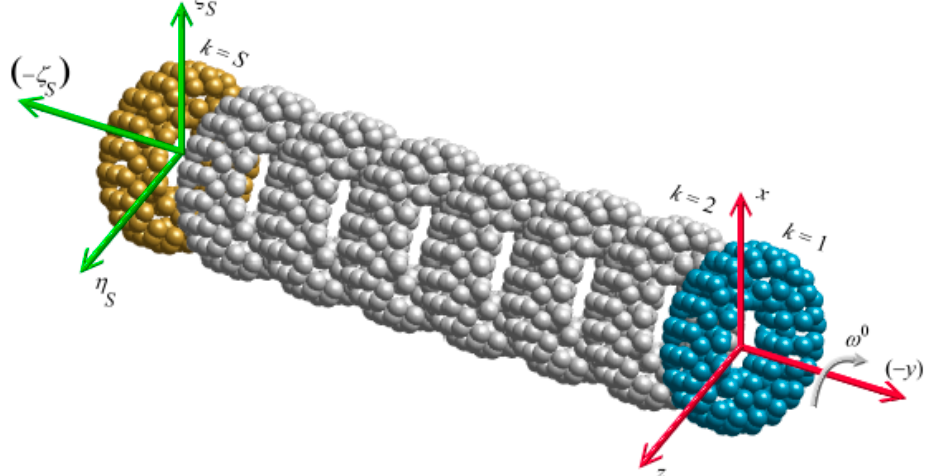
Figure 1. Scheme of nanotori cluster at the initial moment of time.